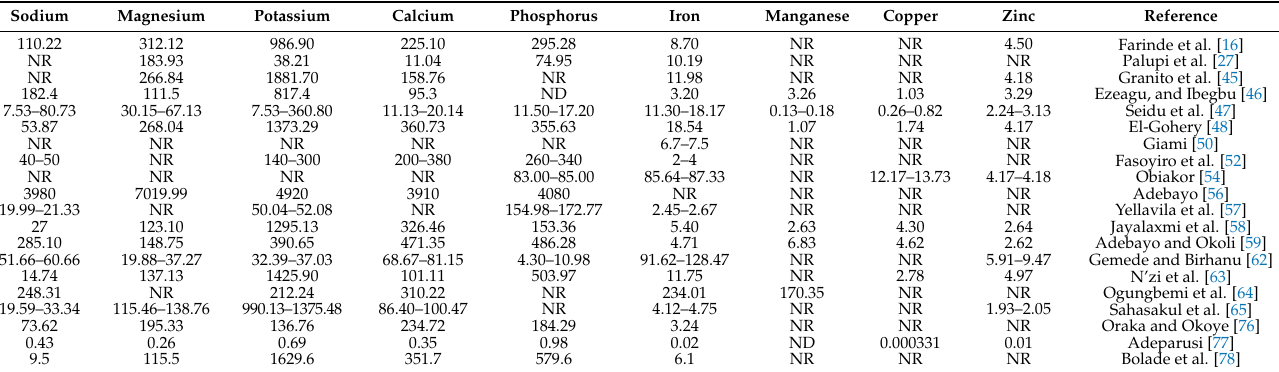
Table 3. Mineral composition (mg/100 g) of lima beans reported in